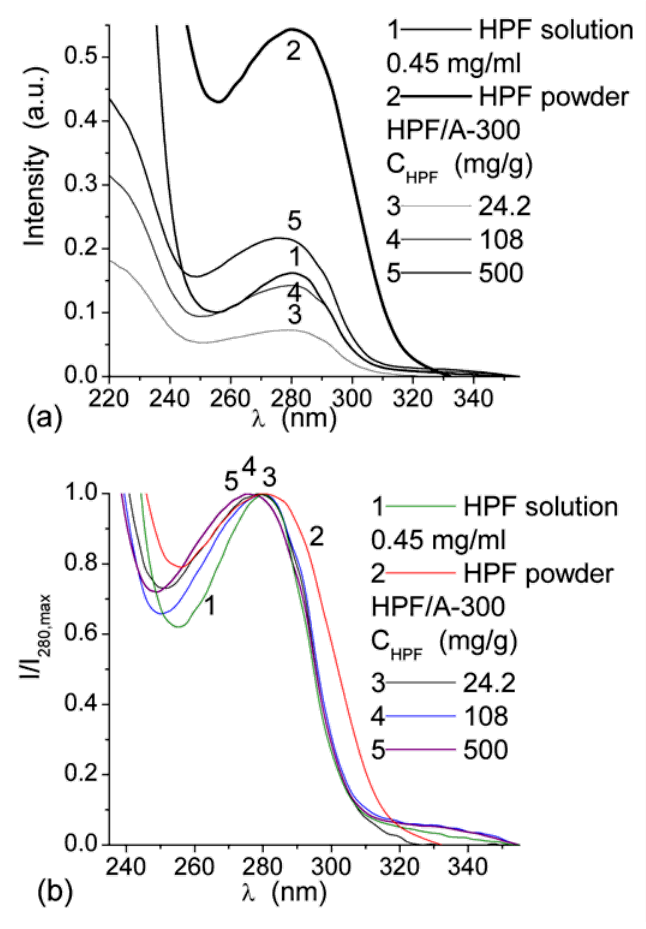
Fig. 3 (a) Electronic reflection spectra of powder and dissolved HPF (0.45 mg/mL, PBS) and HPF adsorbed onto silica, and (b) normalized spectra divided by the intensity value of a maximum at 280